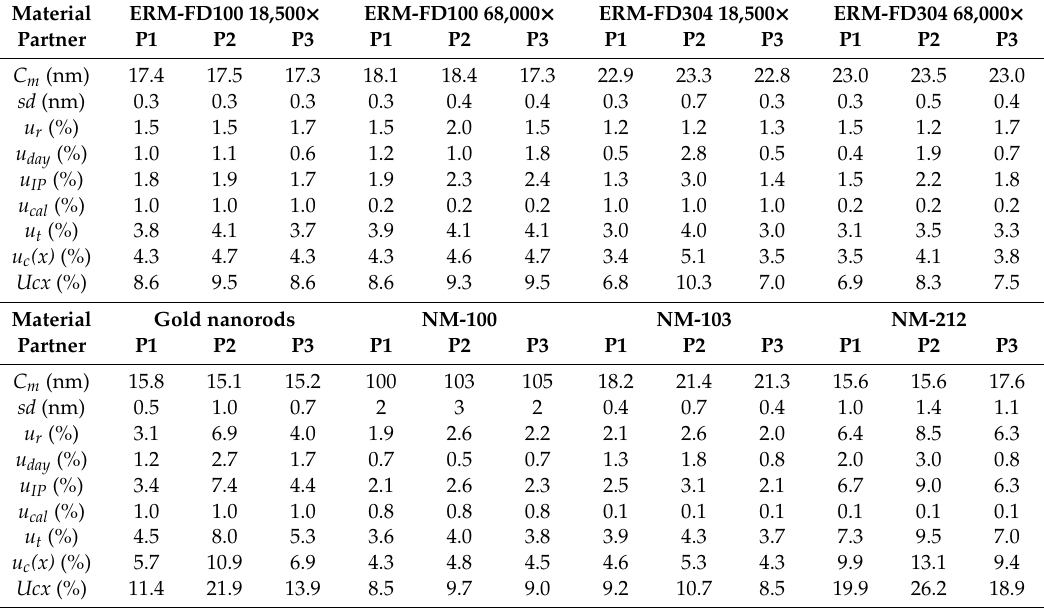
Table 2. Summary of the di ff erent uncertainty contributions to the combined and expanded measurement uncertainties, for the measurement of the median of the minimal Feret diameter distributions of the selected